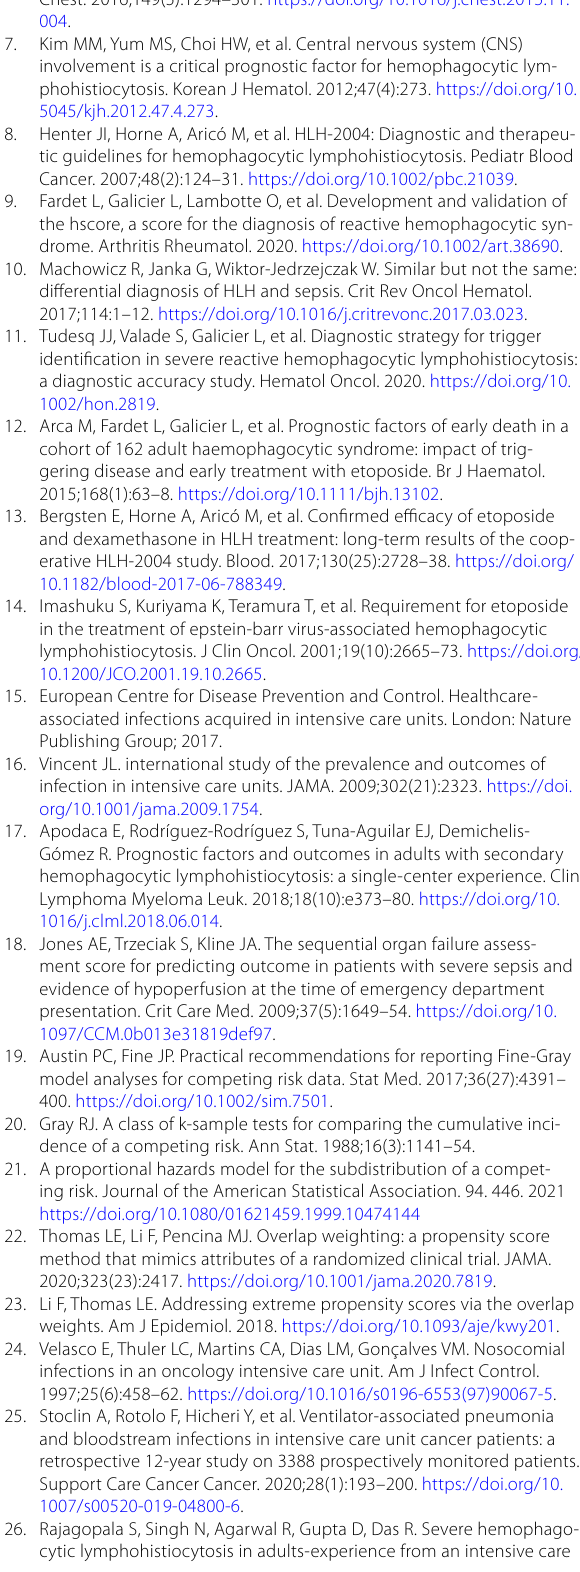
(univariate analysis). Table S5 Causes of death in patients who died in